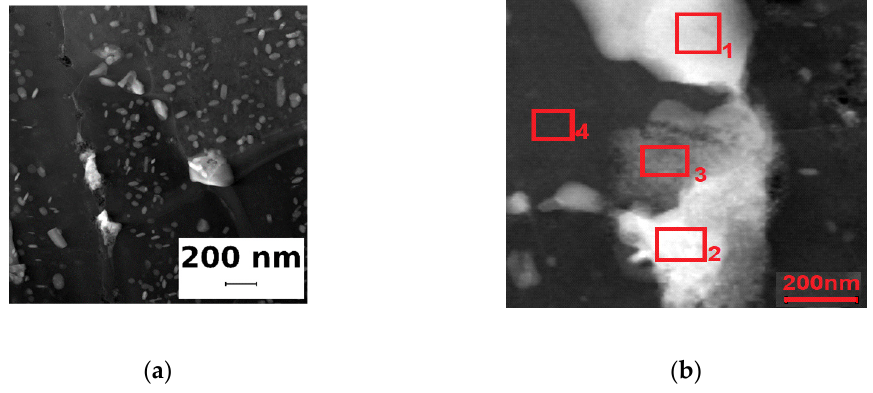
Figure 7. HAADF STEM micrographs of SPS-KOBO extruded AA7075 ( a , b